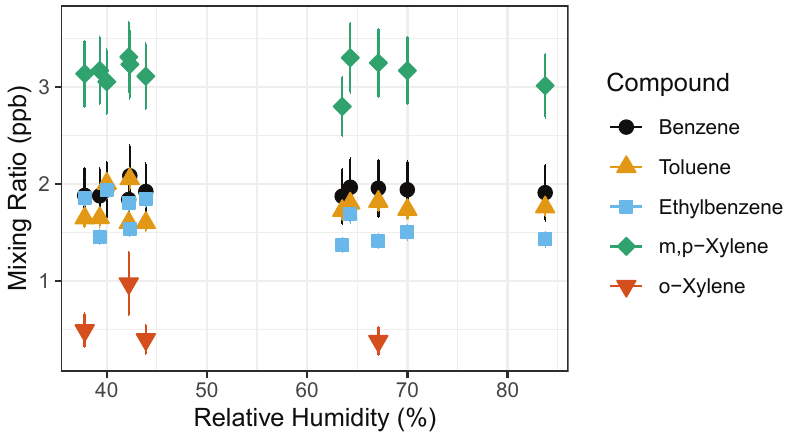
Figure 7. BTEX measured concentration of 1 ppb gas standard. Measured pre-rain event relative humidity (RH) was 30–50%, while the post-rain event occurred during the increased relative hu- midity >50% RH. Error bars represent propagation of uncertainties from gas standard and random instrument